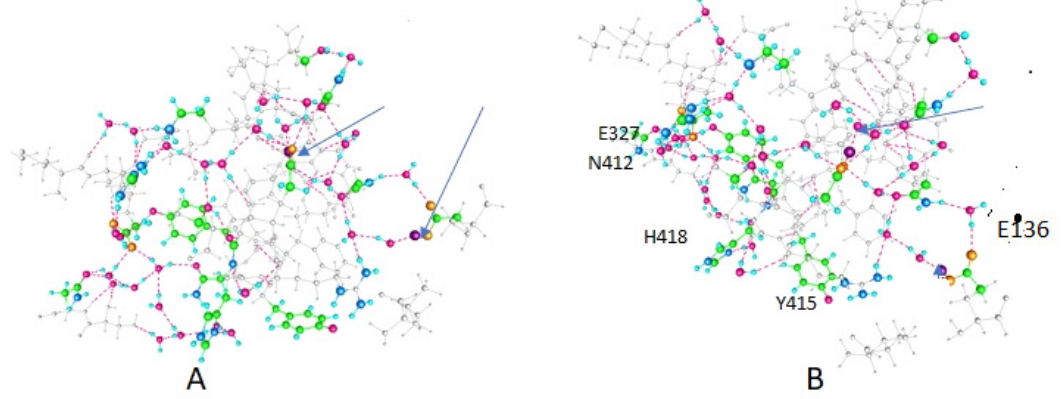
Figure 4. This is the other low energy configuration. All conventions (color code, rotation, arrows for protons) are as in Figures 2 and 3. This case is similar to the X ‐ ray structure. ( A , B ) figures correspond to the (A,B) of Figures 2 and 3; ( B ) contains the labels on specific amino acids.